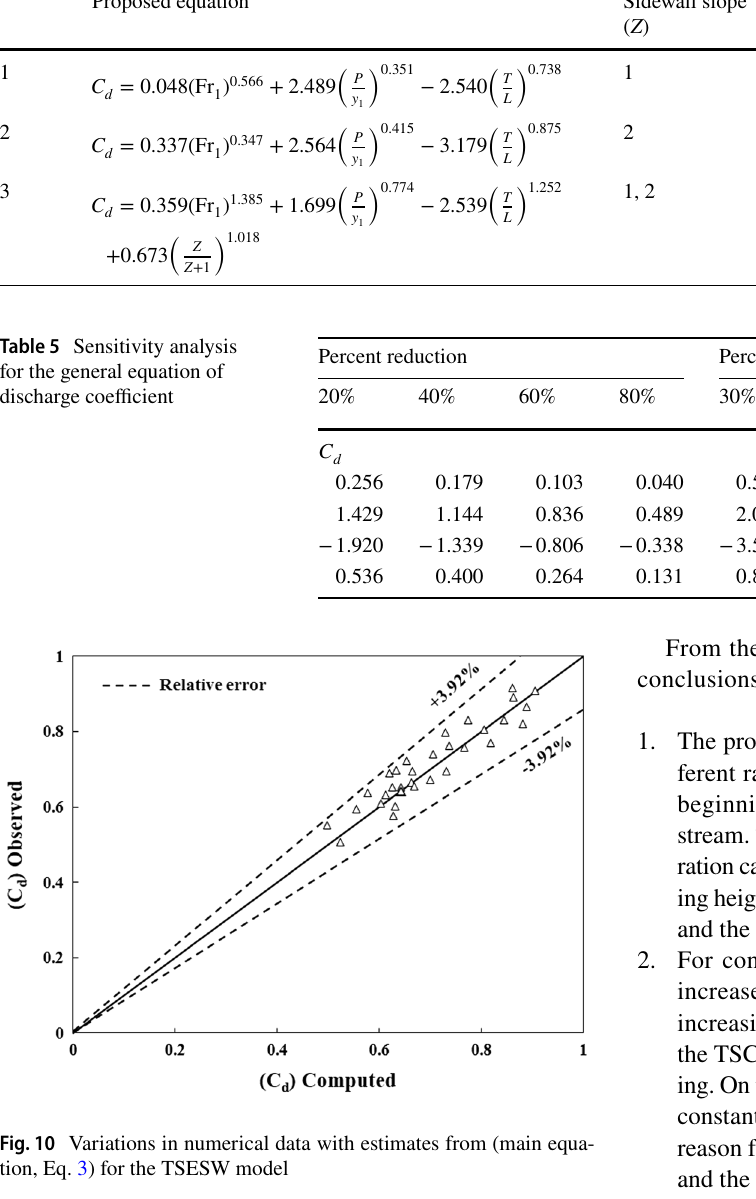
Table 4 Proposed equations for discharge coefficients for various sidewall slopes Proposed equation